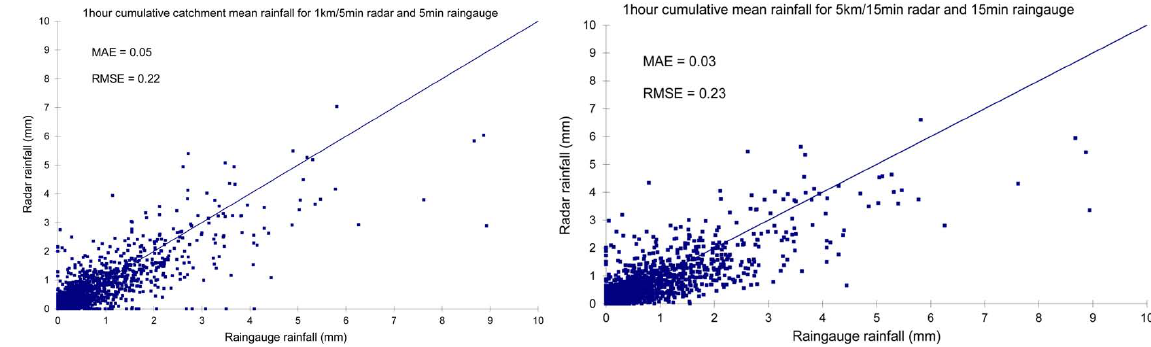
Fig. 5. Comparisons of 1h cumulative catchment rainfall from raingauges and radar at different resolutions.